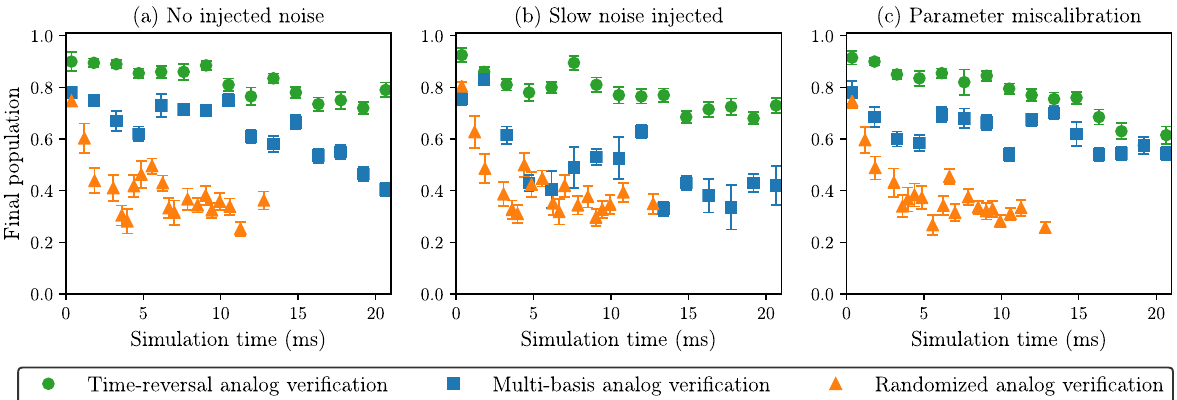
Fig. 5 Experimental results of veri fi cation protocols. Results are for the two-site Ising model from Eq. (22), with J = 2 π × 139 Hz and b = 2 π × 227 Hz. Each plot shows the experimentally-measured population in the expected fi nal state after running each of the veri fi cation protocols under the speci fi ed type of injected noise. Data points represent raw experimental results and include experimental errors due to state preparation, measurement, and imperfect control. For the time-reversal and multi-basis analog veri fi cation protocols, each datapoint represents the distribution of measured results over 200 independent runs. For the randomized analog veri fi cation protocol, each data point represents the distribution of measured results of ten different randomly generated sequences, with each sequence executed 100 times. Error bars indicate standard error of the mean.